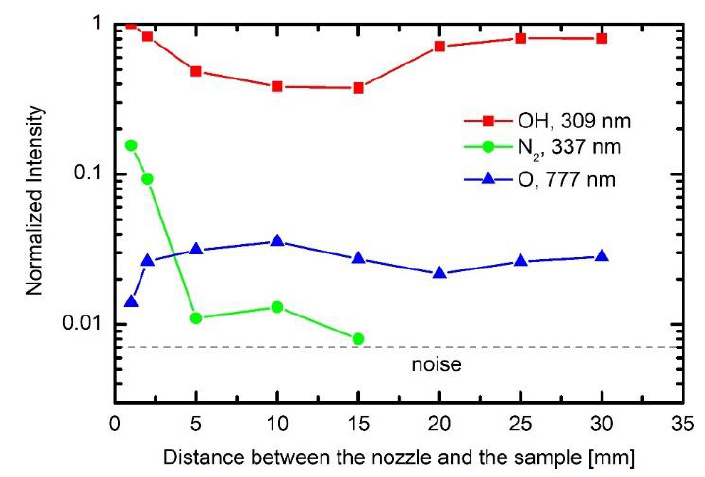
Figure 6. The behavior of normalized spectral features versus the distance between the nozzle and the sample.